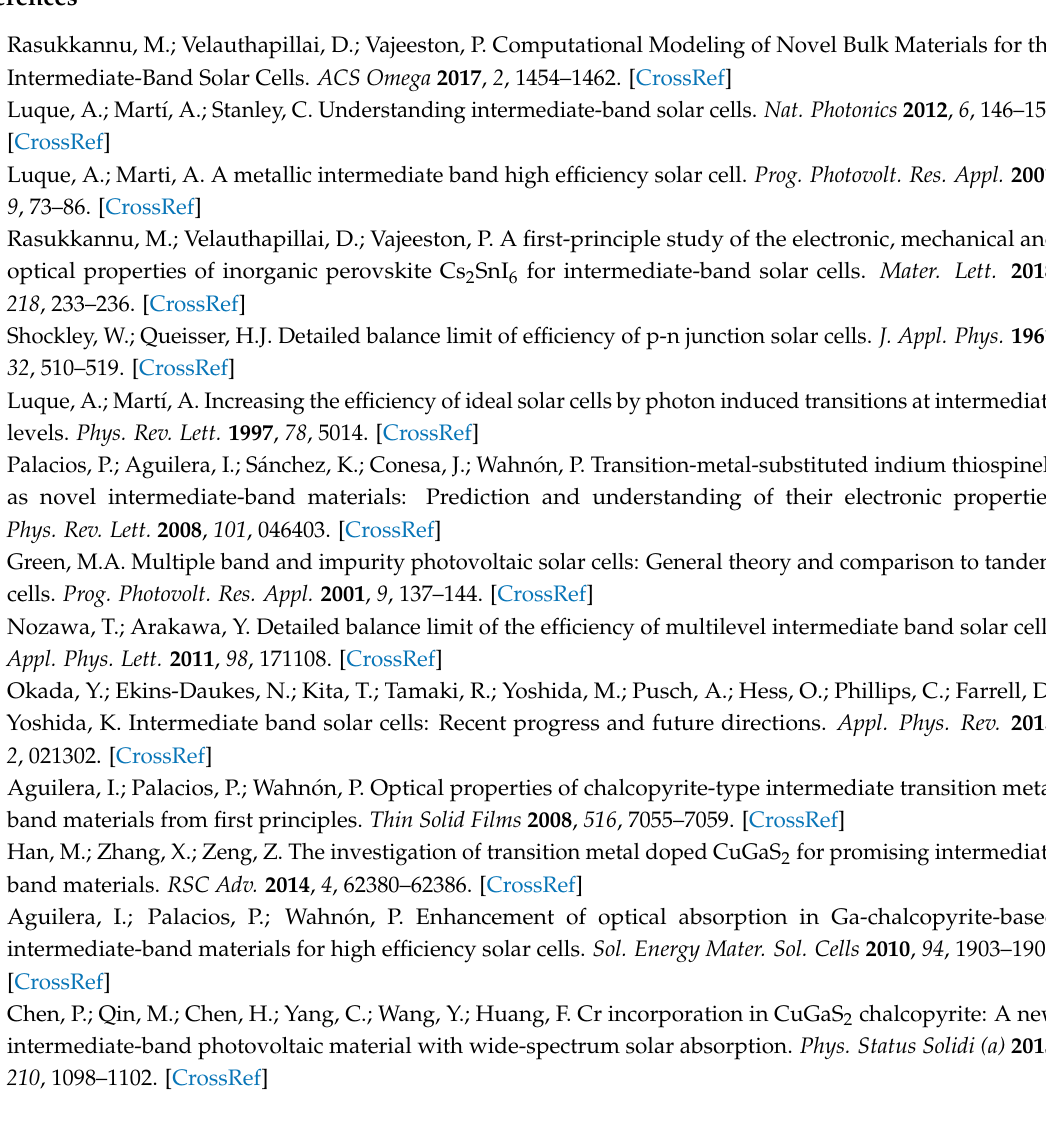
Figure S1: Calculated total and site projected density of states of Ag 2 GeBaS 4 . The Fermi level is set to zero and marked by a vertical dotted line.; Figure S2: Calculated total and site projected density of states of Ag 2 ZnSnS 4 . The Fermi level is set to zero and marked by a vertical dotted line.; Figure S3: Calculated total and site projected density of states of AgCuPO 4 . The Fermi level is set to zero and marked by a vertical dotted line.; Figure S4: Reflectivity of Au 2 Cs 2 I 6 along x, y and z directions.; Figure S5: Reflectivity of Ag 2 GeBaS 4 along x, y and z directions.; Figure S6: Reflectivity of